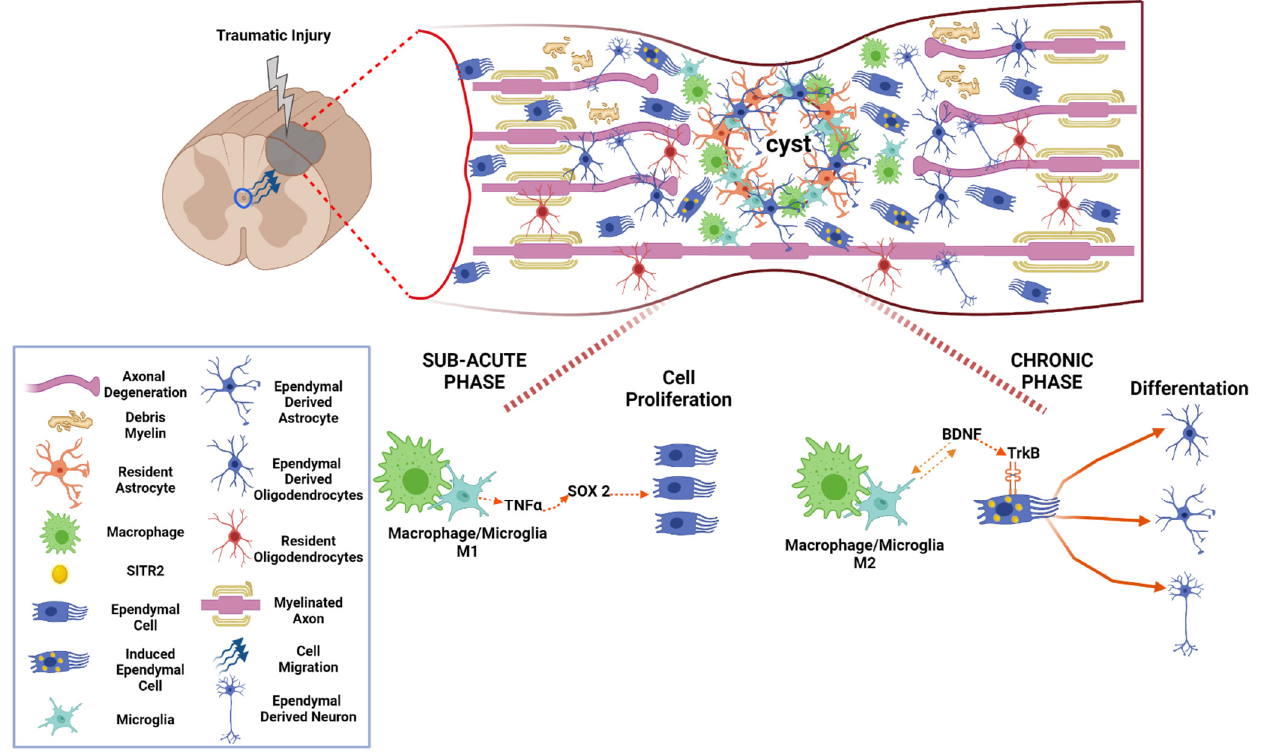
Figure 4. The response of aldynoglia cells in sub-acute and chronic inflammatory phases after SCI. After mechanical damage to the spinal cord, the resident astrocytes near the damaged zone proliferate, enlarge their fibrous processes, produce chondroitin sulfate proteoglycans and form a glial scar containing a cystic cavity in the spinal cord. The ependymal stem cells, EpSCs (a spinal aldynoglia), migrate from the central canal to the injury site; depending on the microenvironment, the EpSCs will proliferate or differentiate. In the sub-acute phase, the TNF- α secreted by macrophages/microglia M1 activates SOX 2, promoting the proliferation of EpSCs. In the chronic phase with the anti-inflammatory microenvironment, the BDNF secreted by macrophages/microglia M2 is attached to the TrkB receptor found in the EpSCs cell surface inducing SITR2 in EpSCs; and promoting its differentiation into astrocytes or oligodendrocytes, which will migrate at fibroglial scar area or remyelinate axons, respectively.